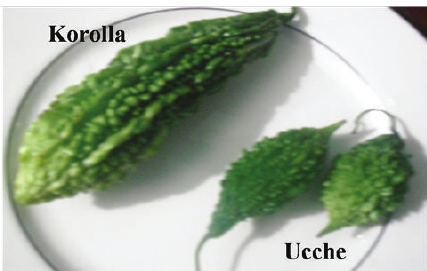
Figure1:Fruitsofdifferentvarietyof Momordicacharantia available in Bangladesh. Upper left one is commonly known as Korolla and right one as